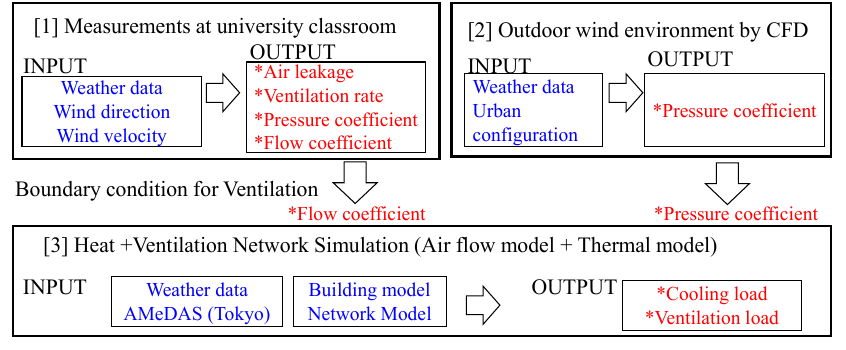
Figure 1. Analysis flow. 111